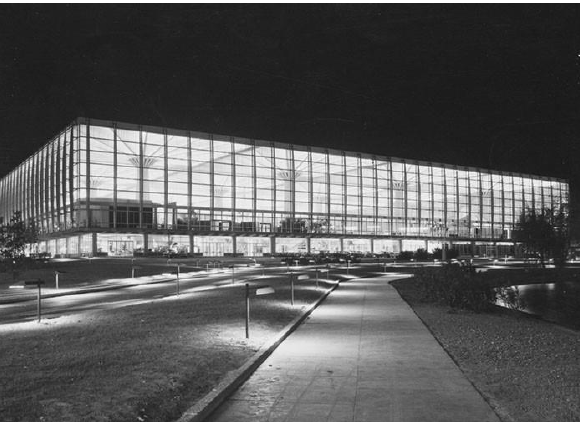
Figure 1: Palazzo del lavoro, night view, 1961. Archivio Storico